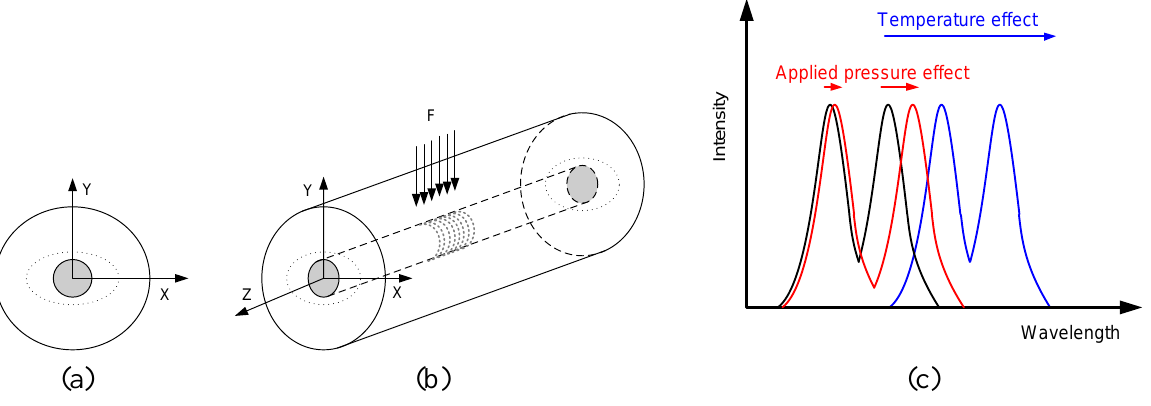
Figure 1. (a) Cross-section of the FBG with marked fiber shape (dashed line) under pressure. (b) Schematic drawing of the FBG with indicated direction of applied